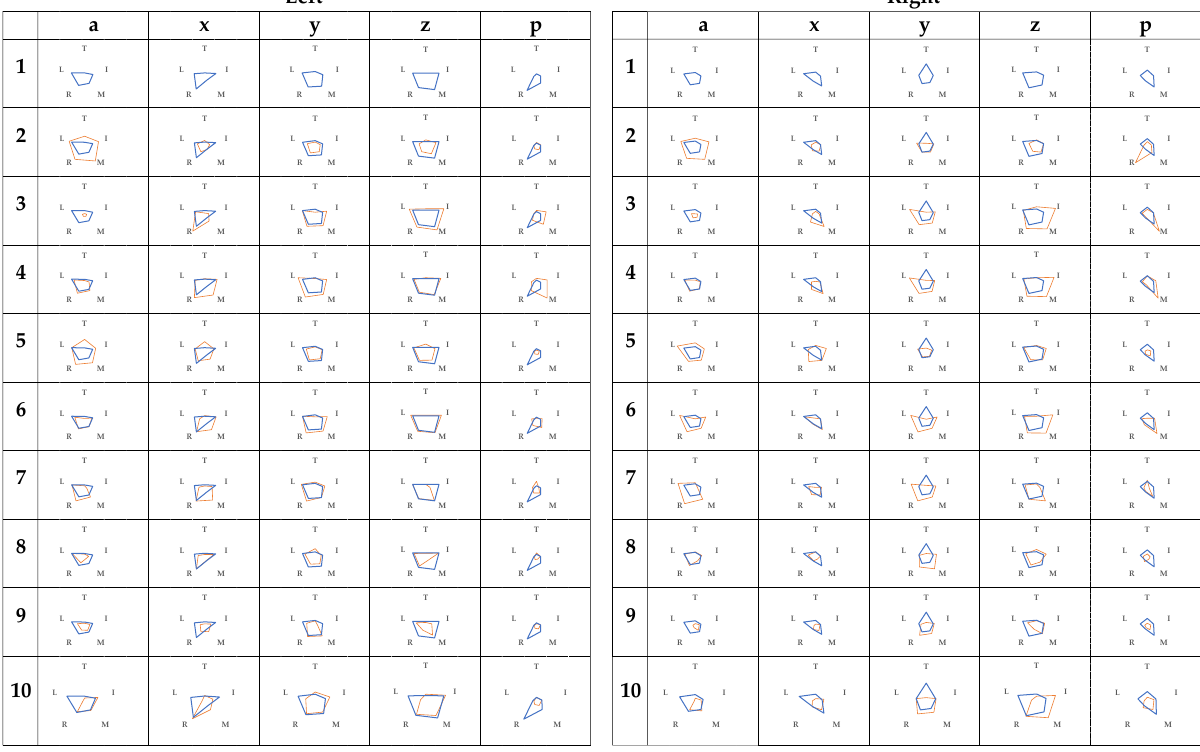
Figure 4. Radar charts of B (Top: thumb, clockwise, index, middle, ring, and little